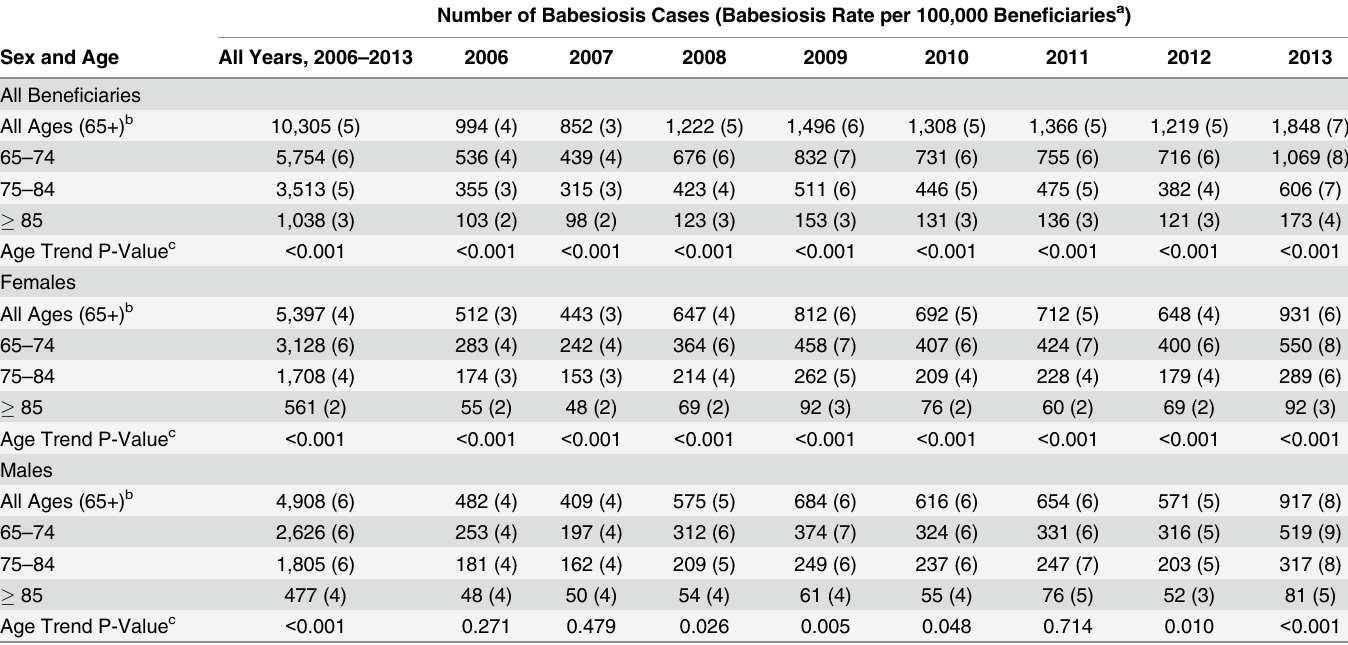
Table 1. Babesiosis Cases and Rates among Elderly Medicare Beneficiaries, Overall, by Sex and Age, During 2006 – 2013.